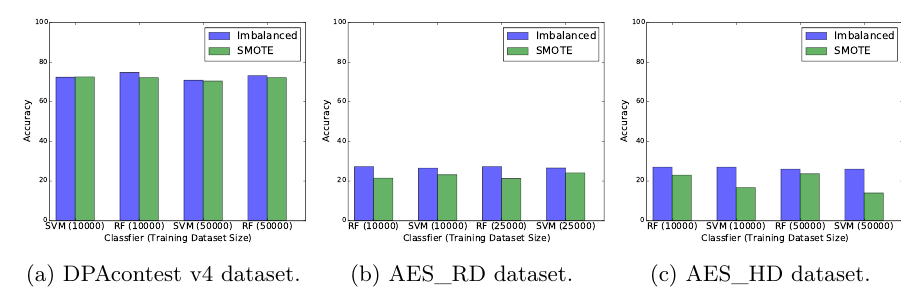
Figure 1: Accuracy for imbalanced and SMOTE on all three